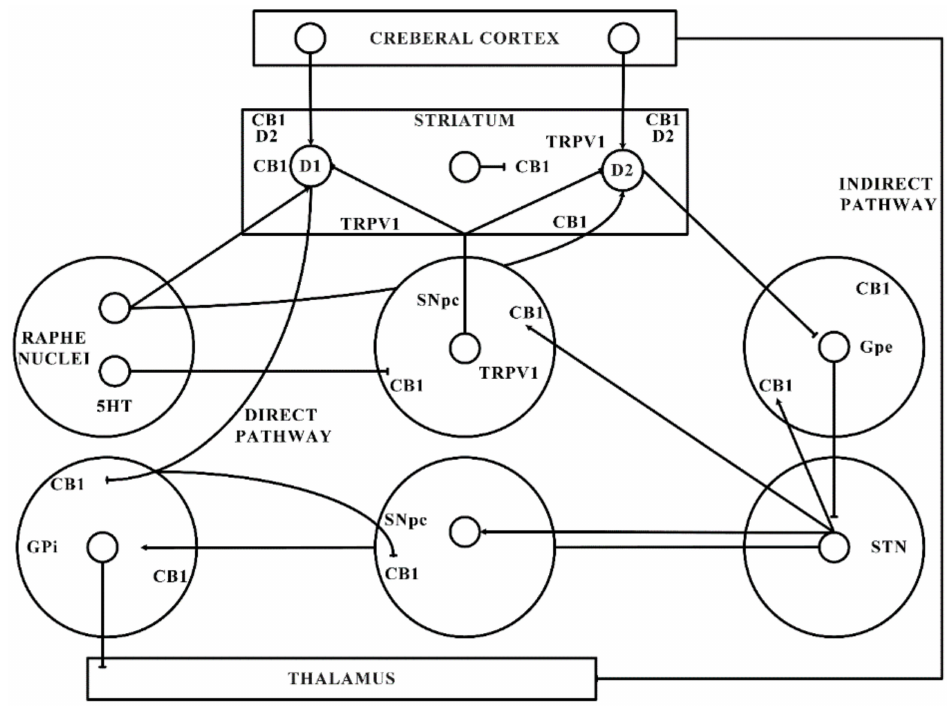
Figure 2. Basal ganglia organization. CB1—Cannabinoid 1 receptor; D1—Dopamine 1 receptor; D2—Dopamine 2 receptor; GABA— γ -aminobutyric acid; GPe—Globus pallidus external; GPi—Globus pallidus internal; SNpc—Substantia nigra pars compacta; STN—subthalamic nucleus; TRPV1—Transient receptor potential